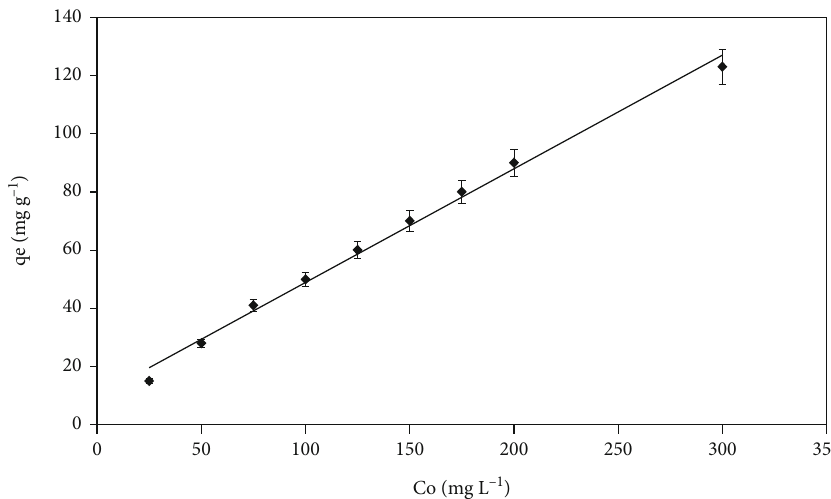
Figure 5: In fl uence of initial concentration on PSS (adsorbent dose: 0.05gL -1 ; room temperature; and contact time: 3hrs).